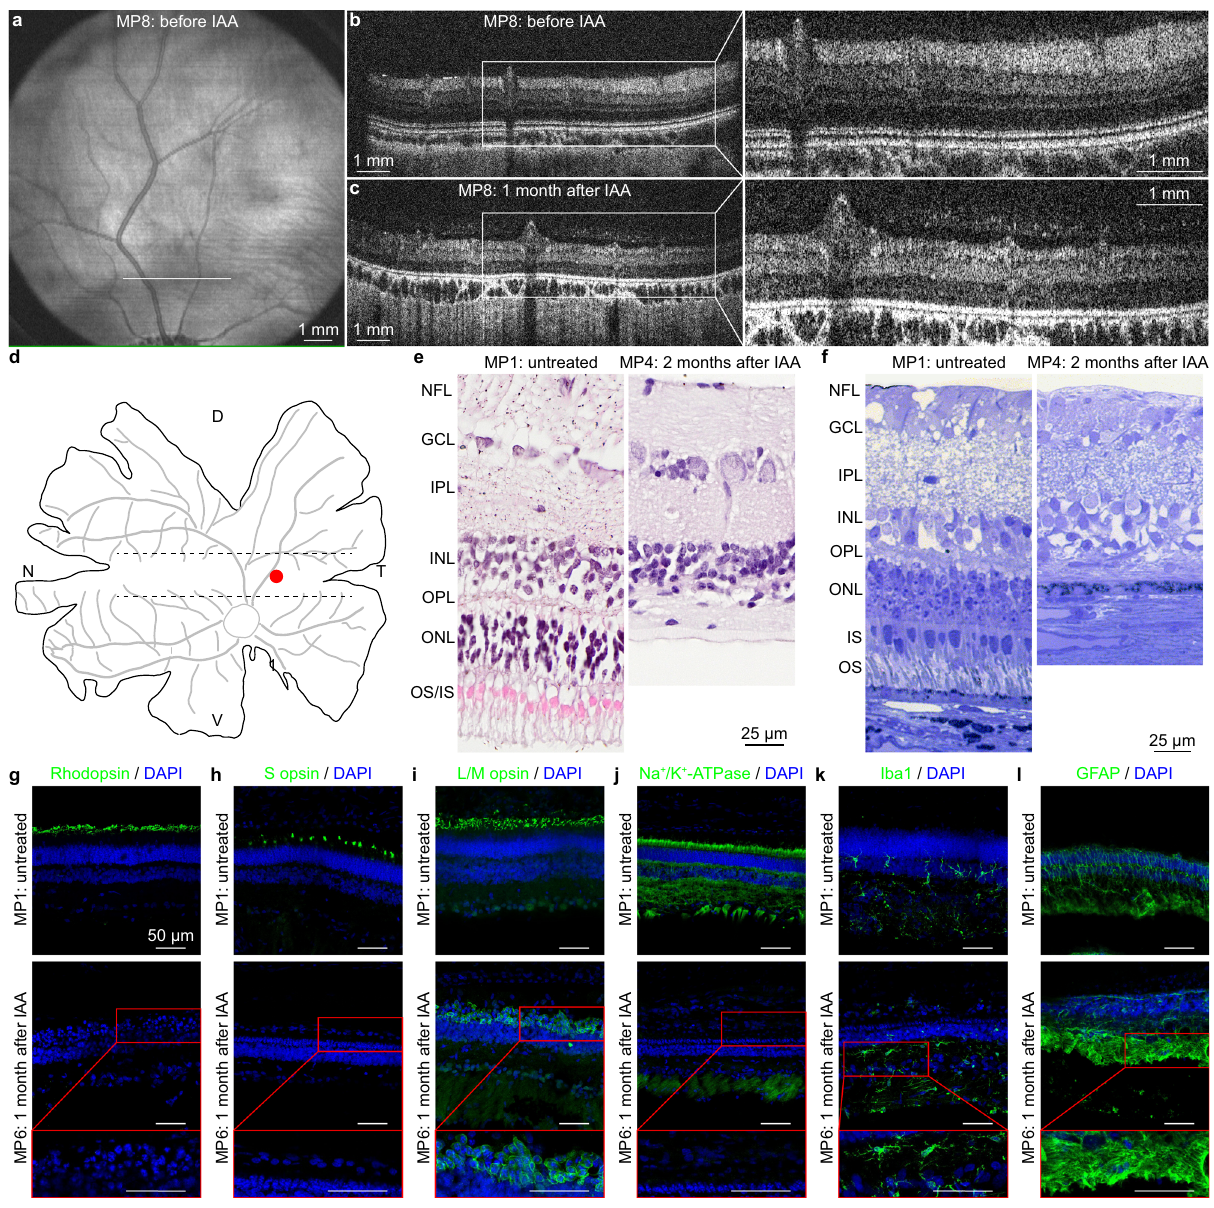
Fig. 1 Retinal imaging in blind minipigs. a Fundus image before IAA administration. b , c SD-OCT images of the retina before and 1 month after IAA administration, taken 2mm above the optic disc (white line in panel a ). The white boxes show a magni fi cation of the retinal sections. Panels a – c are from MP8. d , Drawing of a fl attened retina. The dashed lines delimit the area centralis, while the red circle indicates the point in the area centralis (central temporal) corresponding to the images in panels e – l . D dorsal; T temporal; V ventral; N nasal. e H&E staining of a retinal section in the area centralis (red circle in d ) before and 2 months after IAA administration. NFL nerve fi bre layer; GCL ganglion cell layer; IPL inner plexiform layer; INL inner nuclear layer; OPL outer plexiform layer; ONL outer nuclear layer; IS inner segments; OS outer segments. f , Semithin optical image of a retinal section in the area centralis (red circle in d ) before and 2 months after IAA administration. Images in panels e , f are from MP1 and MP4. g – l IHC staining of a retinal section in the area centralis (red circle in d ) against rhodopsin ( g ), S opsin ( h ), L/M opsin ( i ), Na + /K + -ATPase ( j ), Iba1 ( k ), and GFAP ( l ) before and 1 month after IAA administration. The red inserts show magni fi cations of the retinal sections 1 month after IAA administration. All scale bars in panels g – l are 50 µ m. Images in panels g – l are from MP1 and MP6. H&E and IHC analyses have been performed at various time points ( n = 1 eye from N = 1 minipig per time